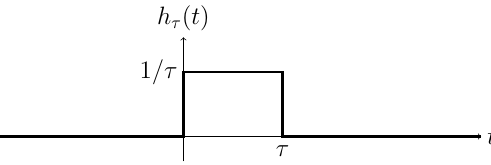
Figure 3: Time window of the statistical